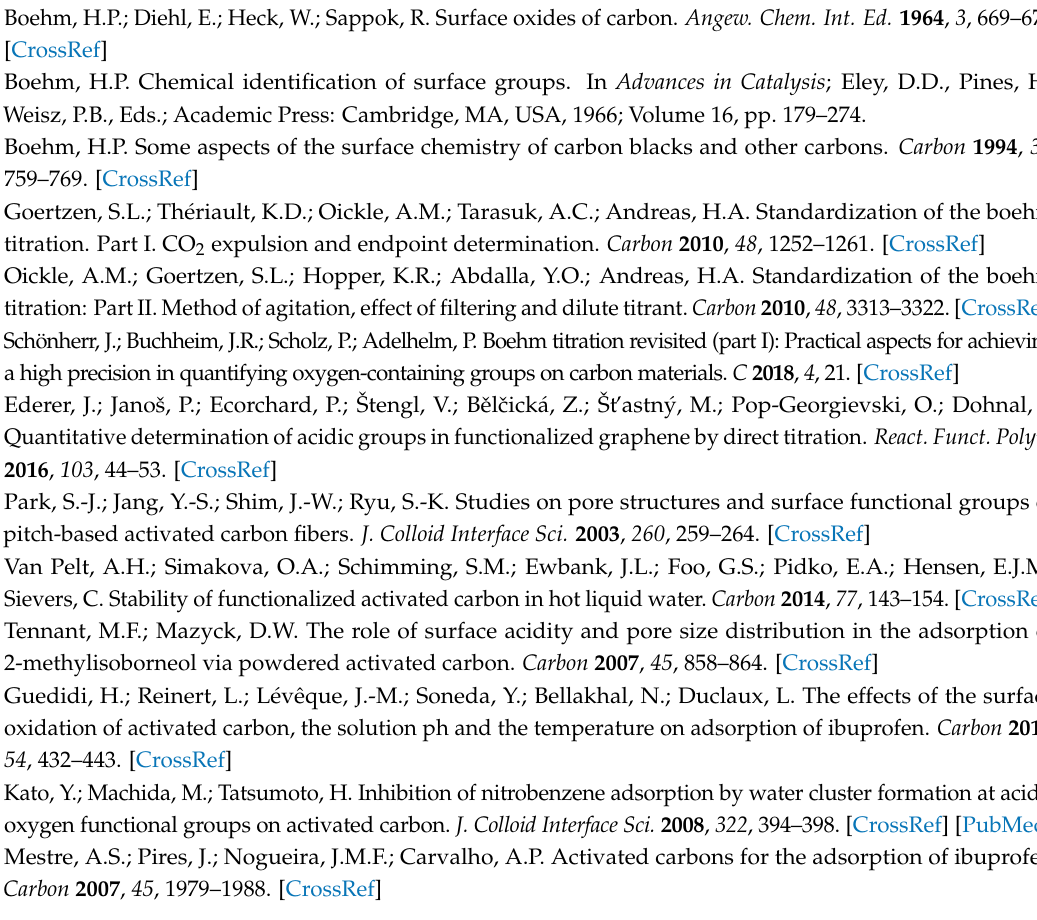
Figure S1: N 2 Isotherms of (a) aCB, (b) aCNTs, (c) aAC1 and (d) aAC2; Figure S2: SEM-Images from (a) aCB, (b) aCNTs, (c) aAC1 and (d) aAC2; Table S1: Specific surface area, pore volume and micropore area of the carbon materials; Figure S3: TPD deconvolution of (a) CO 2 and (b) CO for aAC1; Calculation of total oxygen amount for the BT; Calculation of total oxygen amount for the